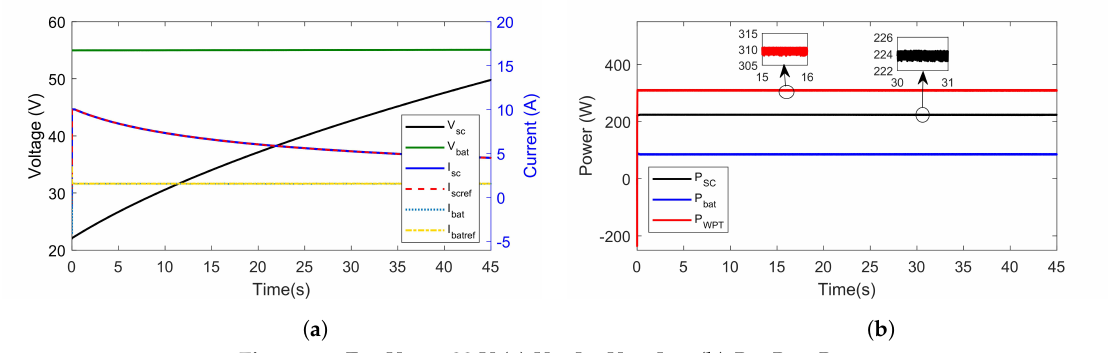
Figure 12. For V sci = 22 V ( a ) V sc , I sc , V bat , I bat , ( b ) P sc , P bat , P wpt . Following the trend, when V sci was equal to 35 V, the constant power mode was used again. The turning power P t for this V sci was calculated as 175 W. However, in this scenario, the SC was fully charged in less time; i.e., 35 s. This charging process is shown in Figure 13a,b where it can be seen that the charging was completed quicker than the rated time of 45 s. To summarize all the scenarios, the turning power for each initial voltage is shown in Table